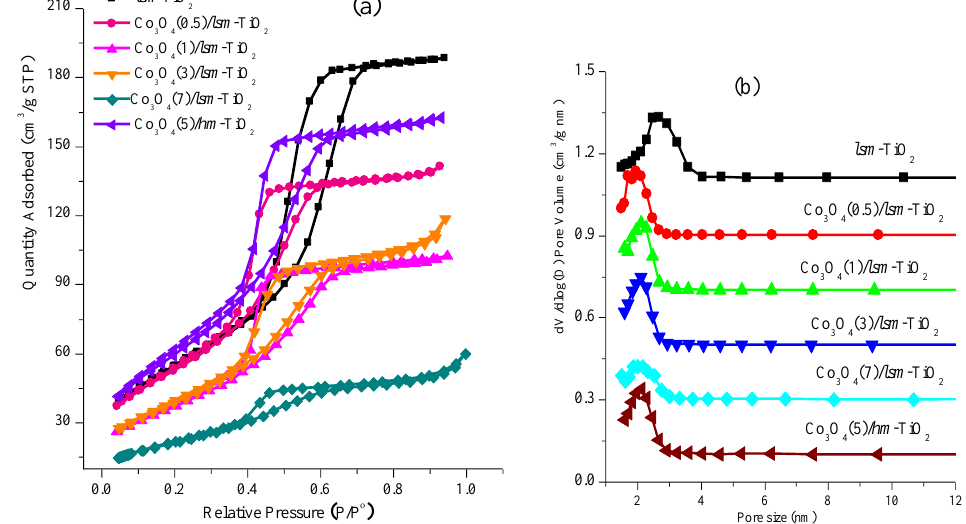
Figure 4. ( a ) The N 2 sorption isotherms and ( b ) corresponding pore size distribution of the lsm -TiO 2 modified with different loadings of cobalt oxide nanoparticles.